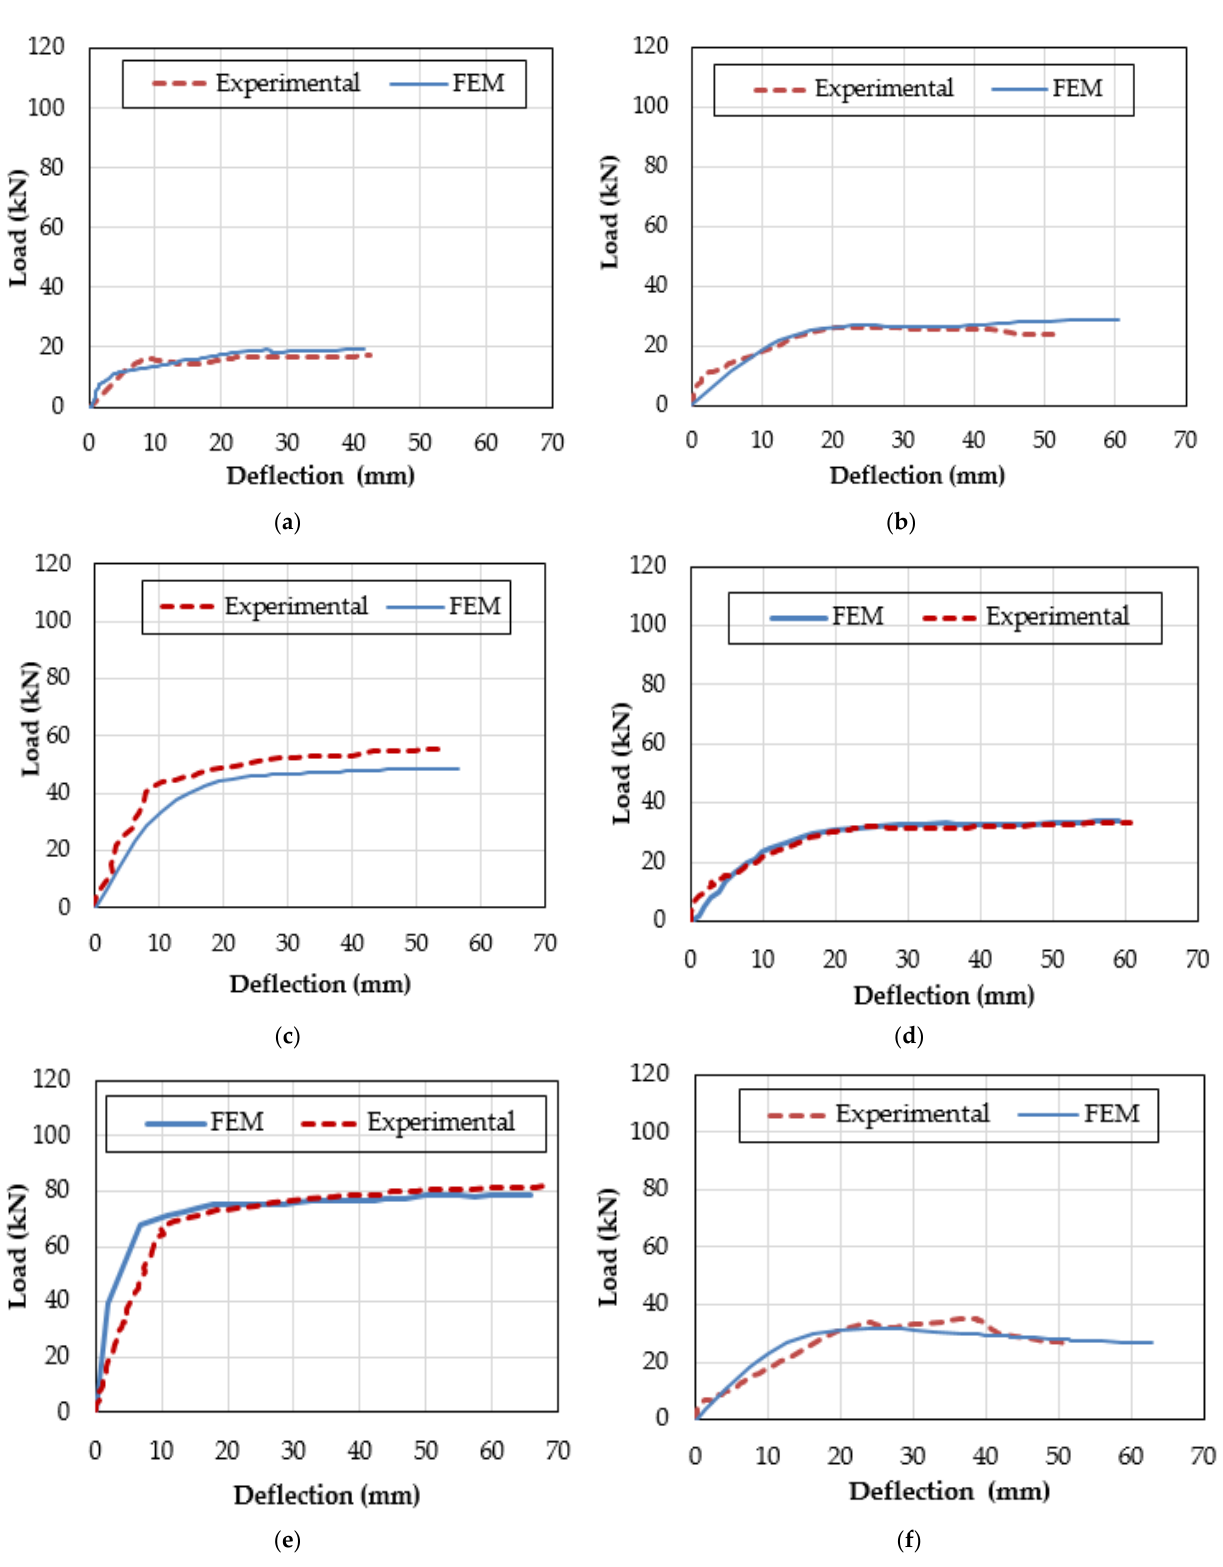
Figure 3. The load–deflection curves for overhanging beams: ( a ) SN8-8; ( b ) GN8-8; ( c ) SN10-10; ( d ) GM10-10; ( e ) SN12-12; and ( f ) GN12-10.